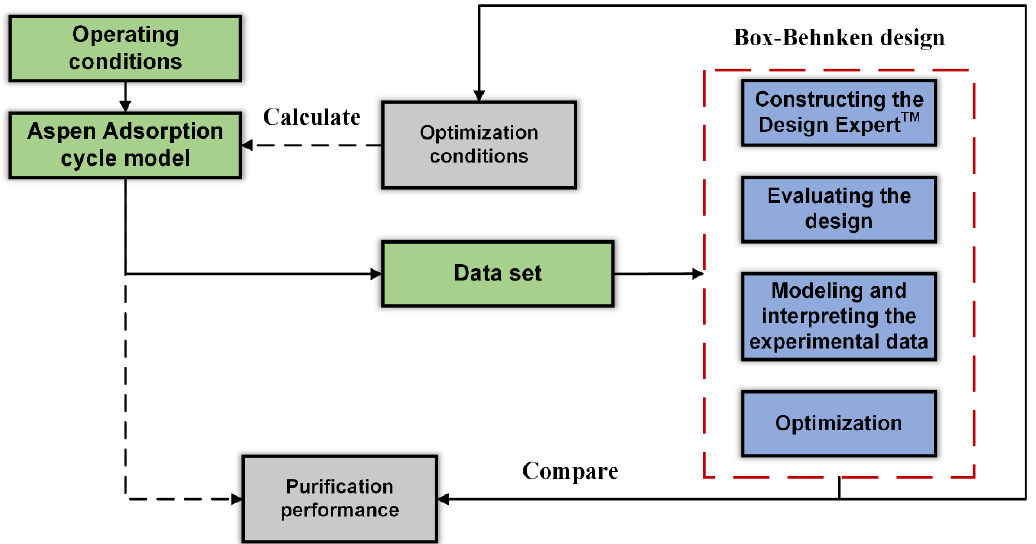
Figure 5. Flow chart of the BBD method for the PSA process cited by Zhang et al. [71]. Readapted with permission from Ref. [71]. Copyright 2021 Elsevier.